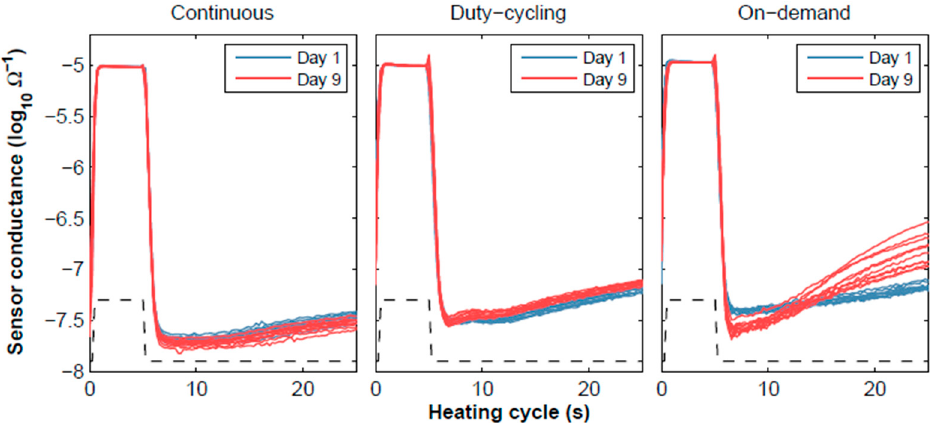
Figure 5. Drift in raw patterns for the three operating modes at 9 ppm of CO. The blue and red solid lines represent the sensor conductance measured during a full heating cycle taken on day 1 and day 9, respectively. The black dashed line represents the heater voltage (a.u.).